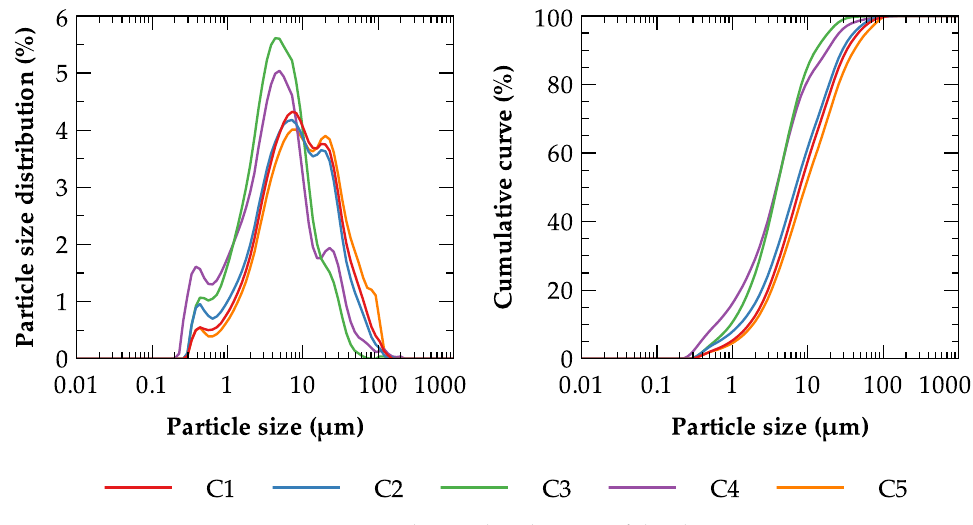
Figure 1. Particle size distributions of the clays. Table 3. Phase composition of the clays (%).